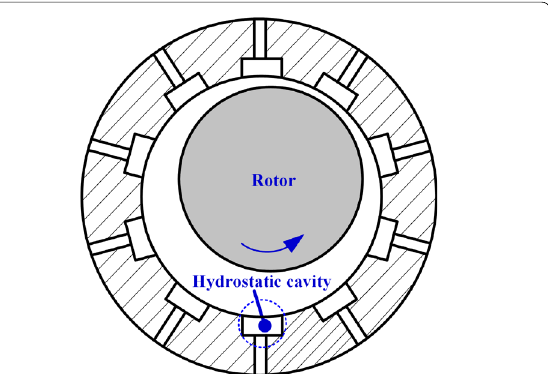
Figure 6 Hybrid fluid-film bearing with ten hydrostatic cavities